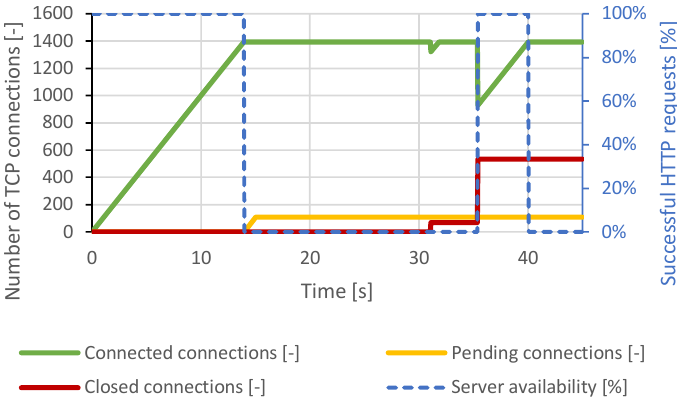
Figure 15. Slow Read attack against lighttpd